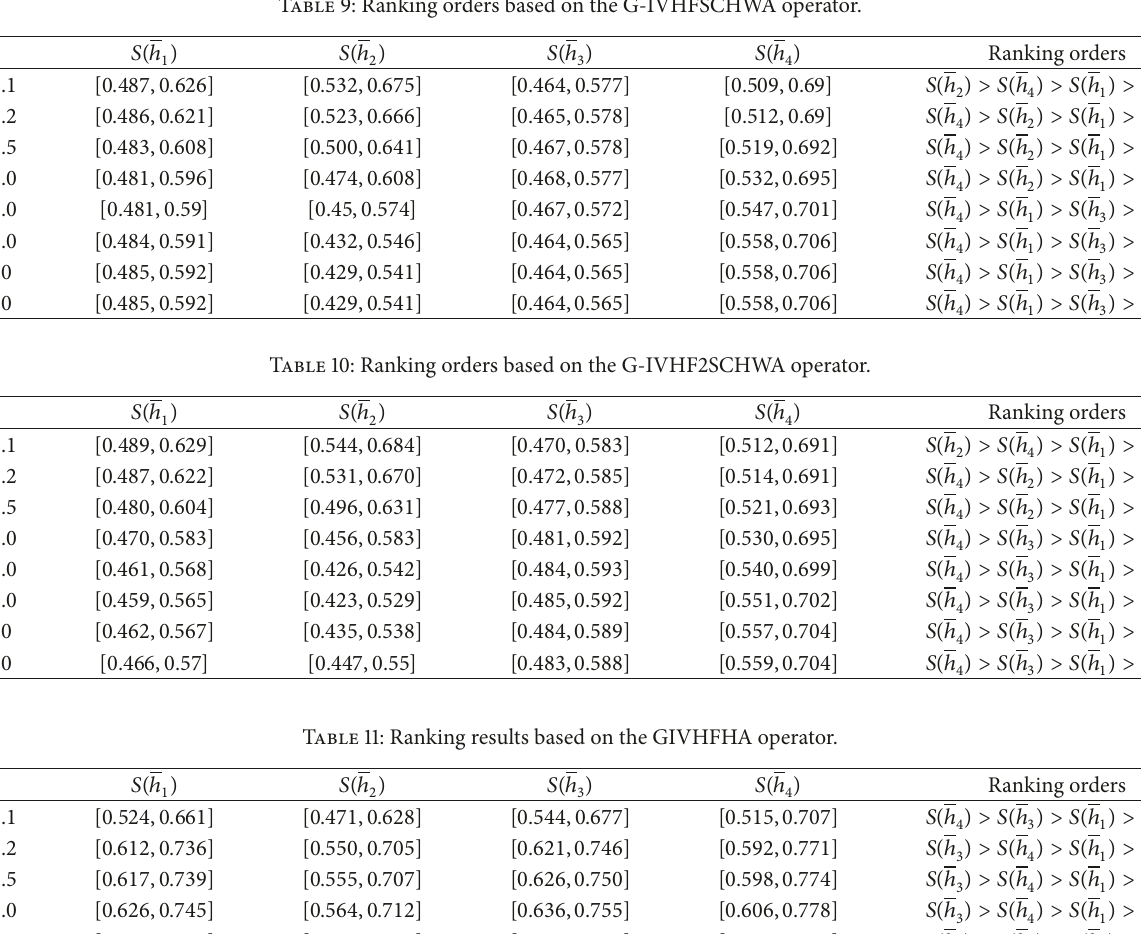
Table 9: Ranking orders based on the G-IVHFSCHWA operator.